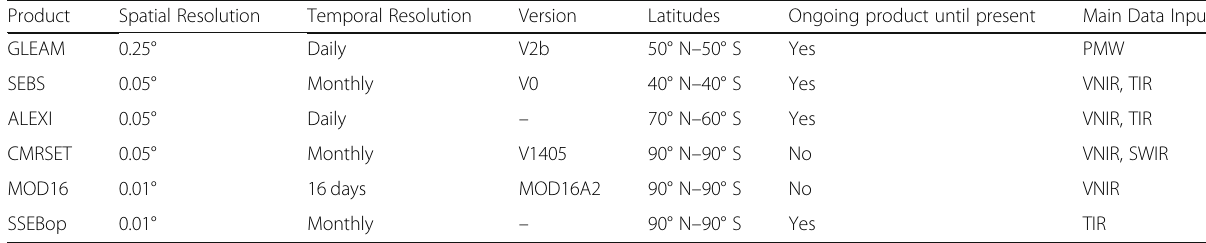
Table 3 Description of the ET products selected for ET-Amazon